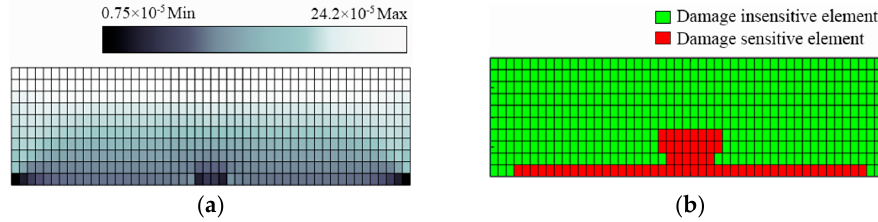
Figure 5. Simulation results for Scenario B with a stiffness reduction of 80%: ( a ) contour for strain variation; ( b ) damage-sensitive area indicated by finite elements in red.